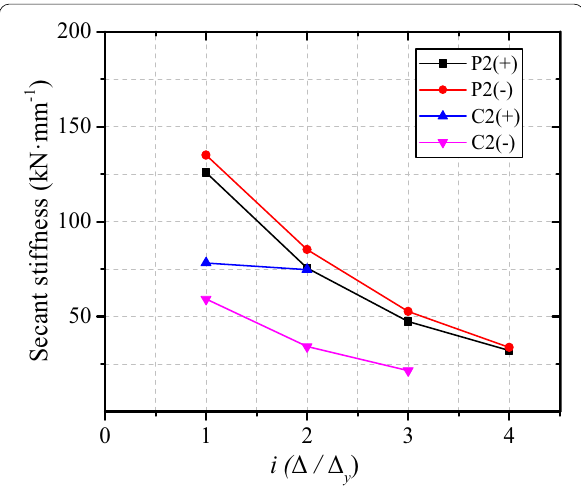
Fig. 21 Degradation of the specimen stiffness.